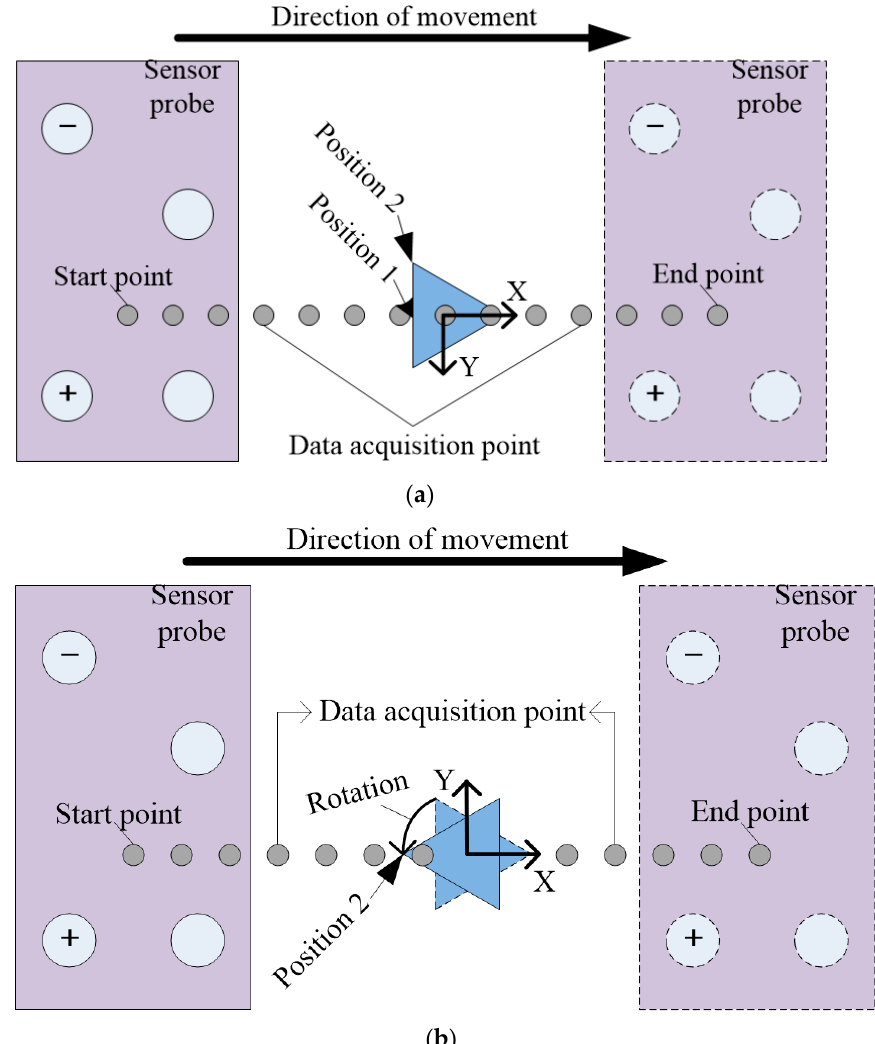
Figure 5. ( a ) Schematic diagram of the relative movement of the sensor probe and the triangular pyramid. ( b ) Schematic diagram of the movement orientation of the detection device and its relative position with the triangular pyramid.